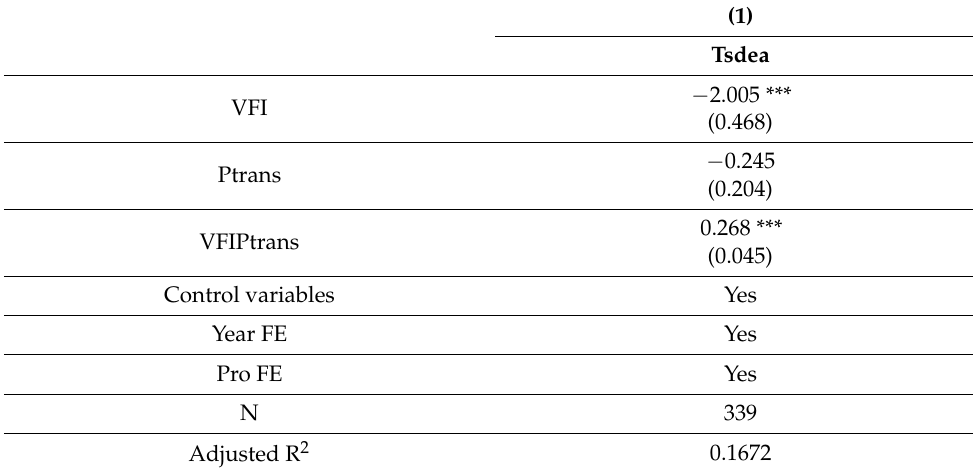
Table 8. Heterogeneity analysis of the impact of vertical fiscal imbalance on fiscal health expenditure efficiency in